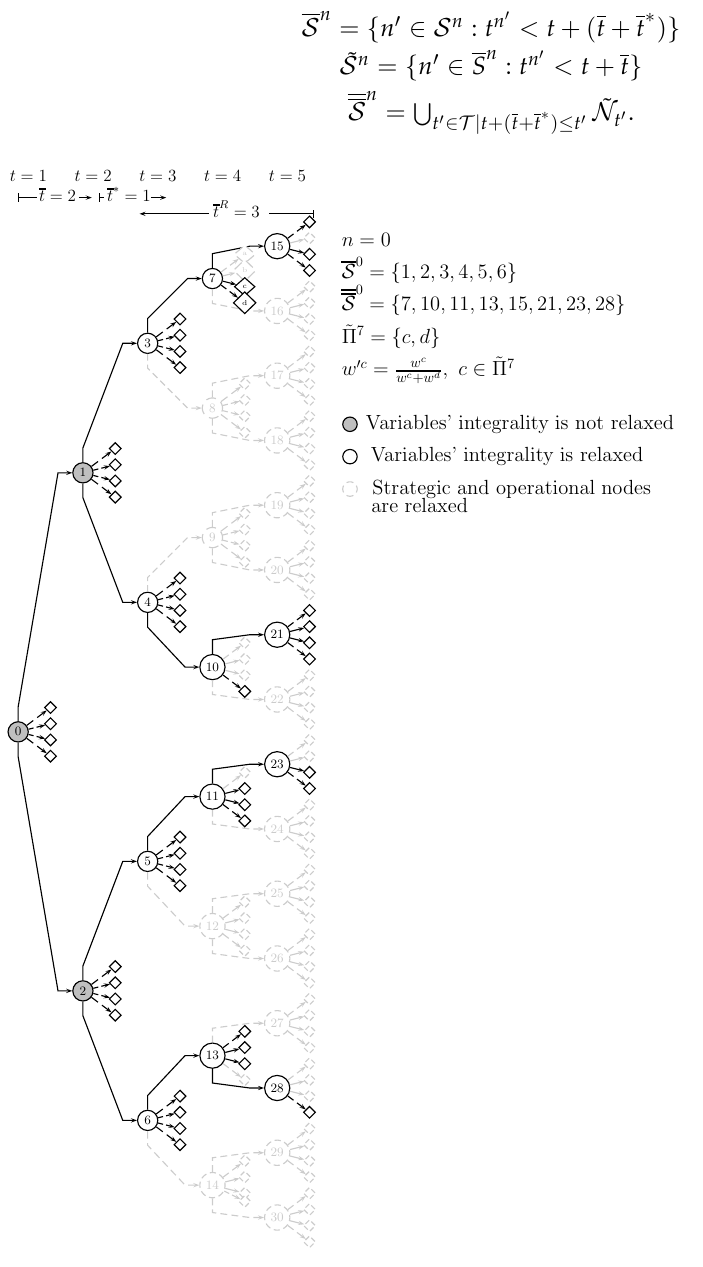
Figure 4. Strategic multistage scenario tree with operational two-stage scenario trees. SFR3 strategic and operational nodes’